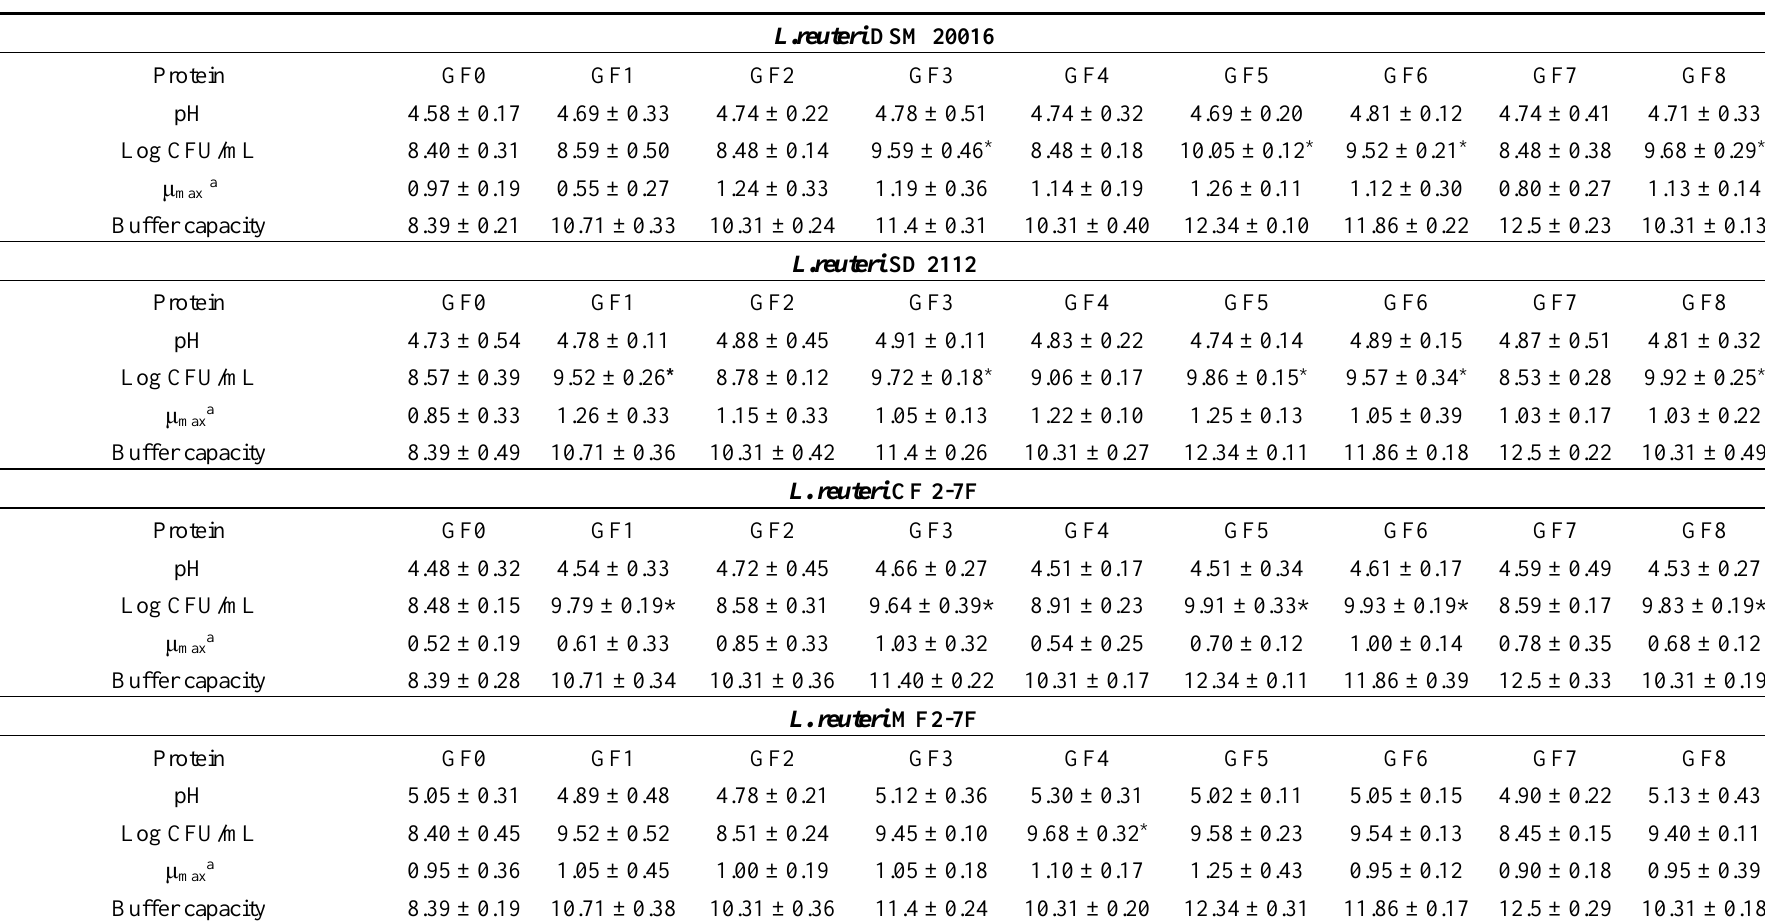
Table 2. Impact of different protein sources on pH values, growth (cfu/mL), and buffering capacity for L. reuteri strains during incubation at 37 °C for 15